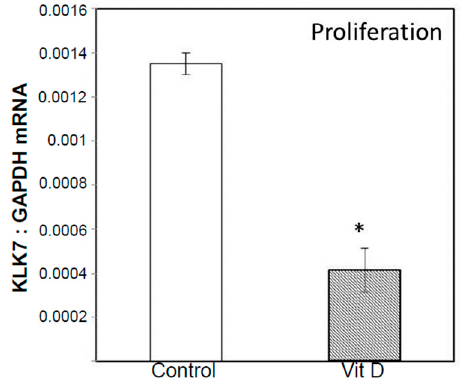
Figure 6. Detection of reduced KLK7 mRNA expression in 1 α ,25(OH) 2 D 3 treated 143B cells by RT-qPCR. Asterisk represents statistical significance of p ≤ 0.05.